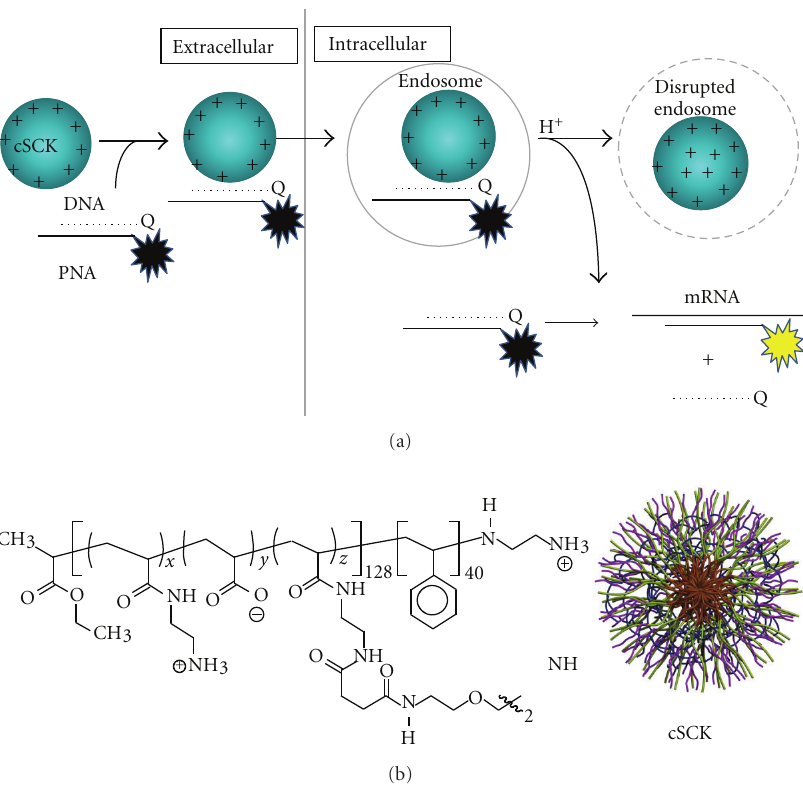
Figure 1: Schematic representation of cSCK-mediated delivery of strand-displacement-activated PNA · DNA probes for imaging mRNA in living cells. (a) The probes consist of a fluorescently labeled nondegradable antisense PNA (peptide nucleic acid) hybridized to a shorter negatively charged complementary DNA strand bearing a quencher, leaving a short single-stranded section of PNA (the toehold). The nonfluorescent PNA • DNA duplex probe is then electrostatically bound to the cationic-shell-crosslinked knedel-like nanoparticle (cSCK). The positive nature of the cSCK facilitates its endocytosis, and the presence of unprotonated amines facilitates disruption of the endosome by the proton-sponge e ff ect which enables the strand-displacement probe to escape into the cytoplasm. Binding of the toe-hold portion of the PNA to the target mRNA sequence then facilitates strand displacement of the quenching DNA strand by branch migration and results in restoration of fluorescence to the PNA strand. (b) Structure of the cSCK formed by crosslinking the block copolymers following micellization x ≈ 122, y ≈ 0, z ≈